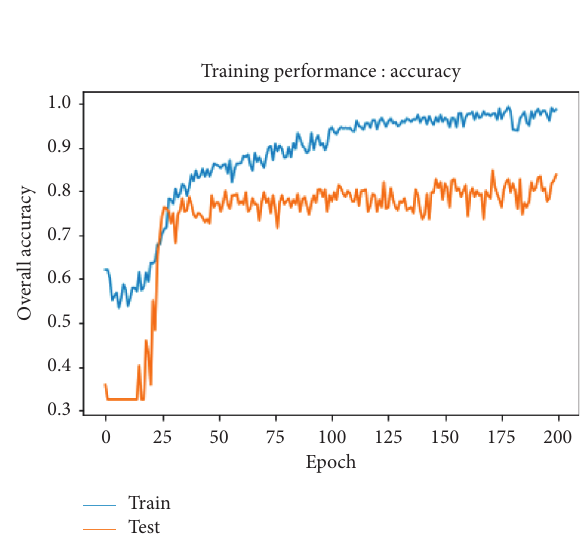
Figure 5: The overall accuracy on the training set and the accuracy on the validation set for the proposed model